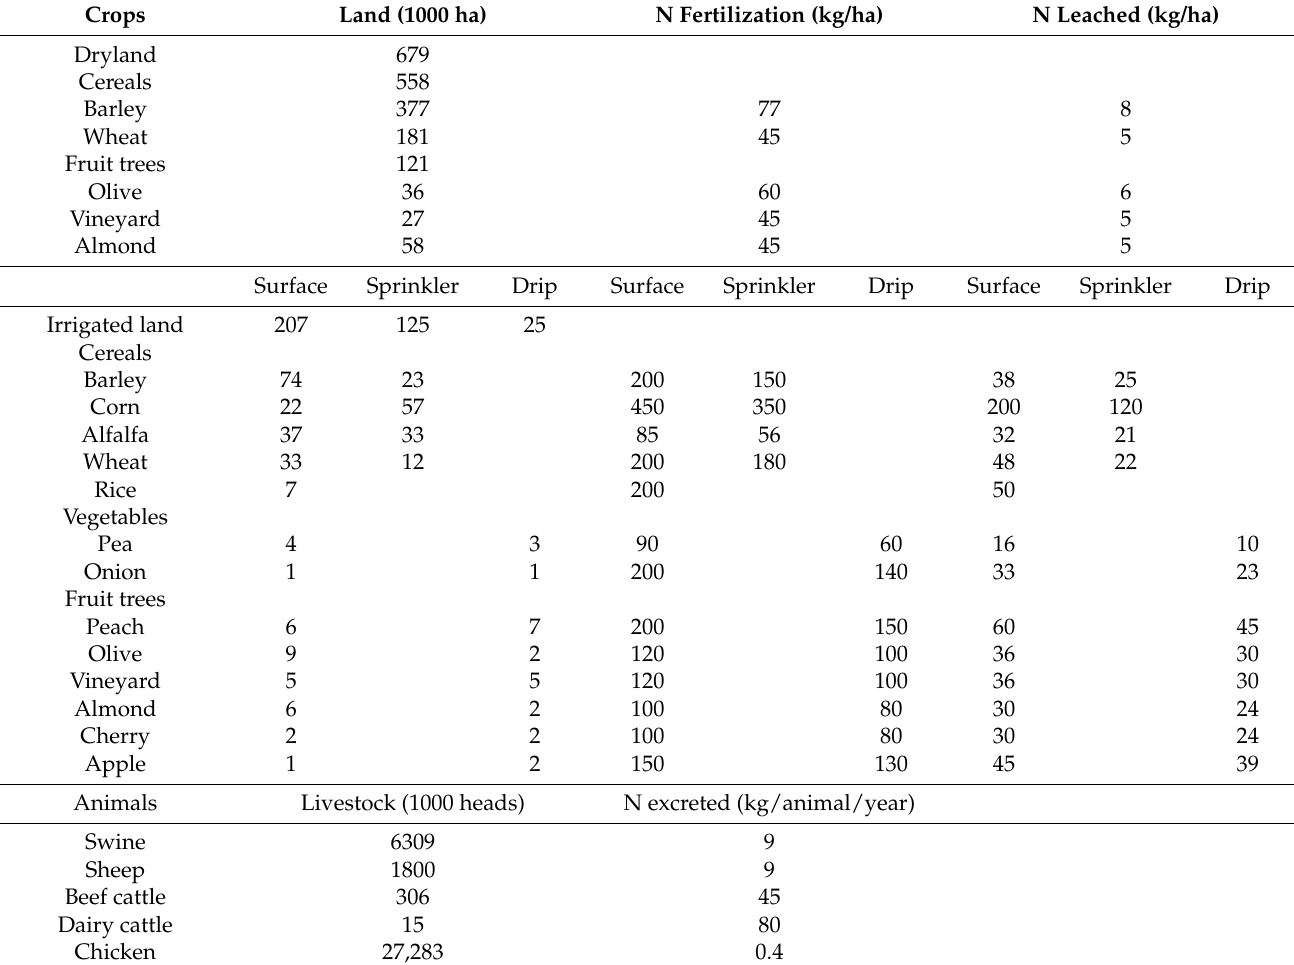
Table 2. Land, animals and nitrogen data used in the calculation of GHG